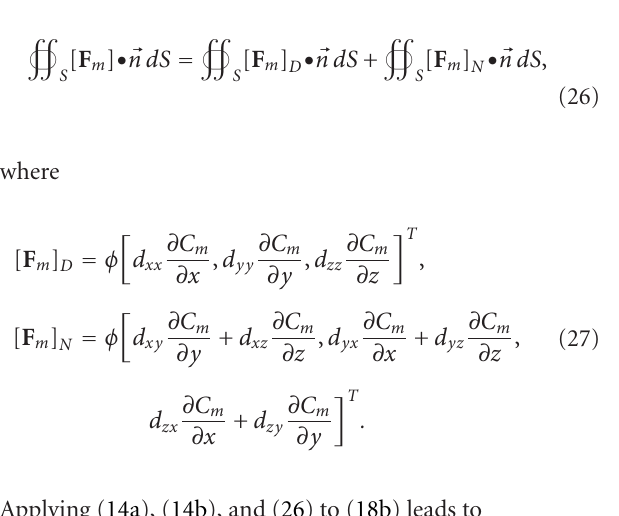
Figure 6: Photo of the recharge